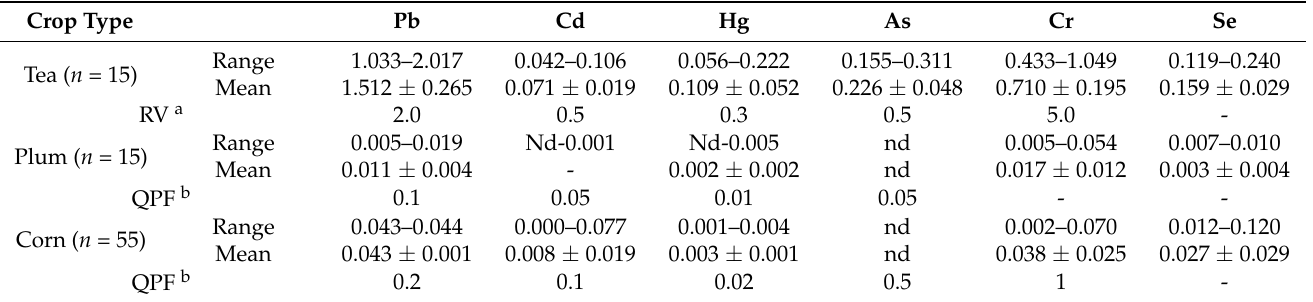
Table 5. Descriptive statistical analysis for HM concentrations (mg/kg) in crops in the study area.